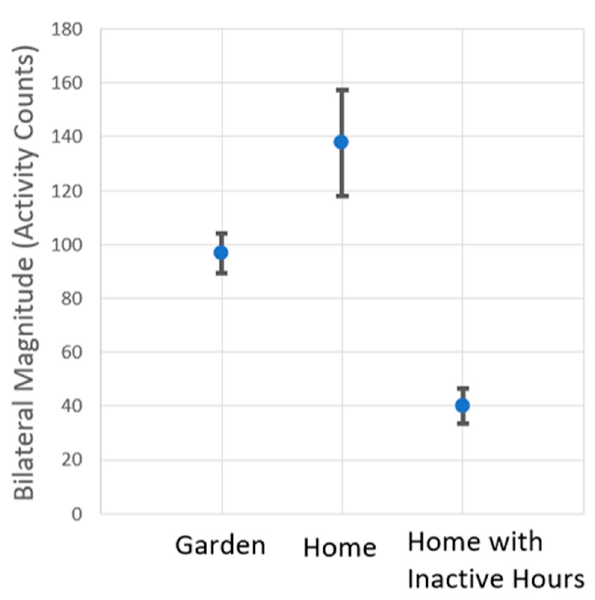
Figure 5. A visual t-test comparing the median bilateral magnitude for activity in the garden (Garden), most active hours of the home (Home), and total waking hours the sensors were worn in the home (Home with inactive hours). The mean of the median bilateral magnitude was 96.7 activity counts for the garden sessions, 137.7 activity counts for the most active hours of the home, and 40.0 for the total hours at home. The standard error was 8.1 for the garden, 19.7 for the most active hours at home, and 6.6 for the total measured hours at